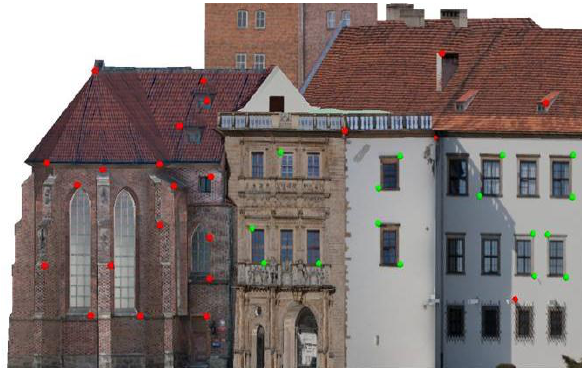
Figure 7. Example of referenced points location - vector (red) and texture (green) elements of model.